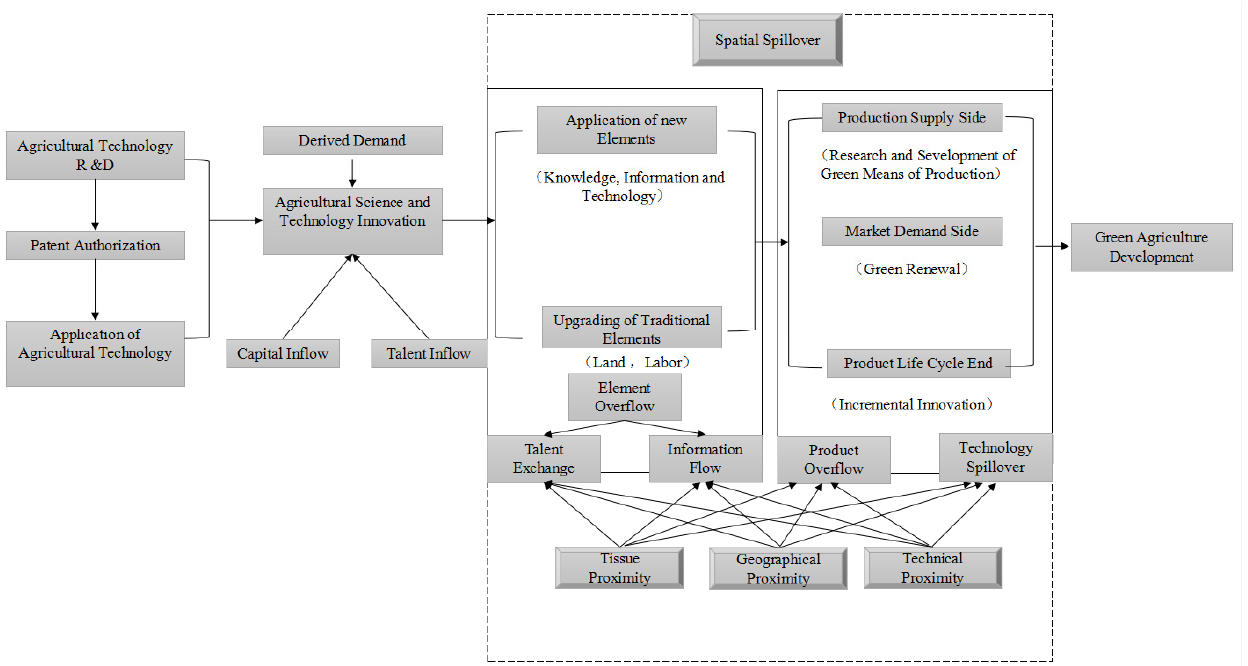
Figure 1. The mechanism diagram of the effect of agricultural science and technology innovation on agricultural green development.